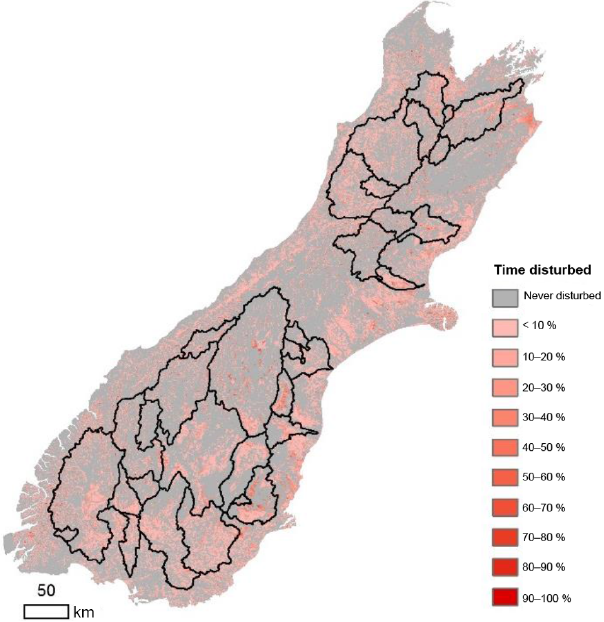
Figure 4. Disturbance frequency of South Island per 463m pixel, based on interpretation of MODIS data